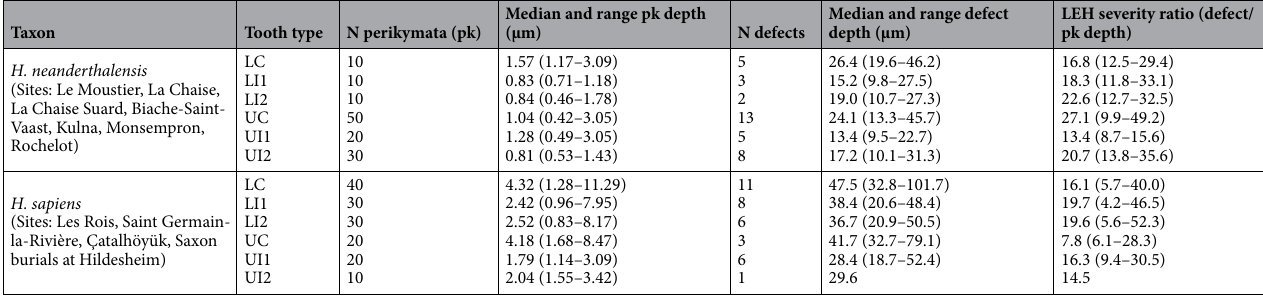
Table 1. Perikymata and LEH defect depths by